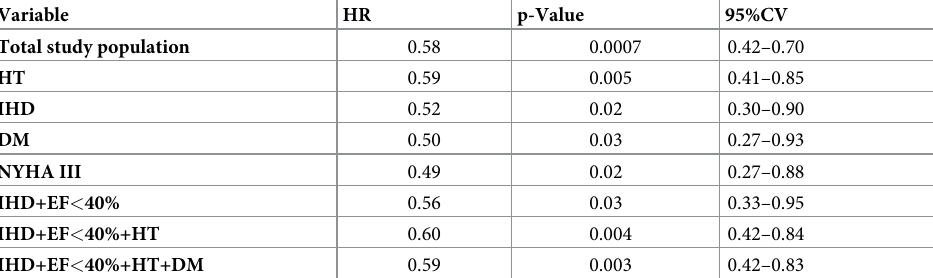
Table 3. Model testing the effect of intervention after 12 years on risk for cardiovascular mortality in different groups.